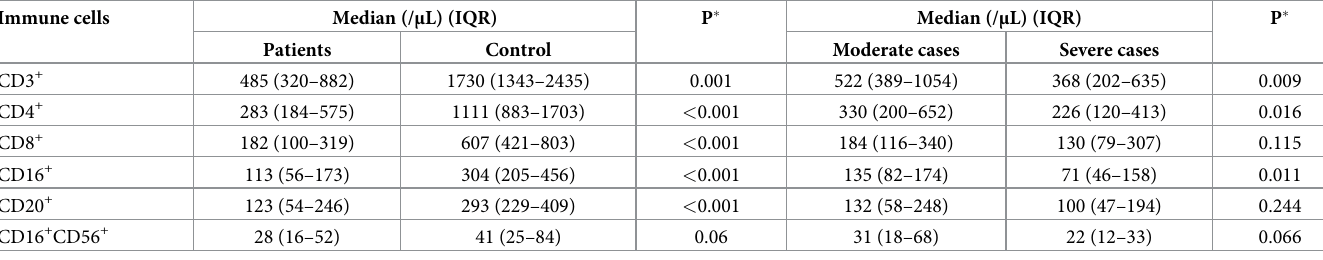
Table 3. Comparison of immune cells in patients (severe and moderate cases) and controls. Immune